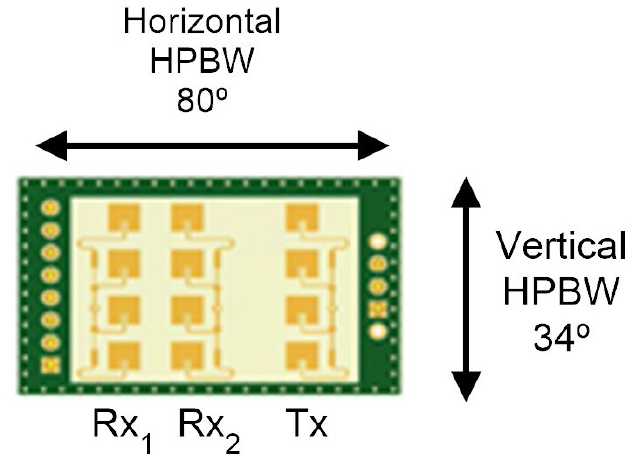
Figure 13. Detail of the receiving and transmitting antenna arrays and HPBW in the horizontal and vertical